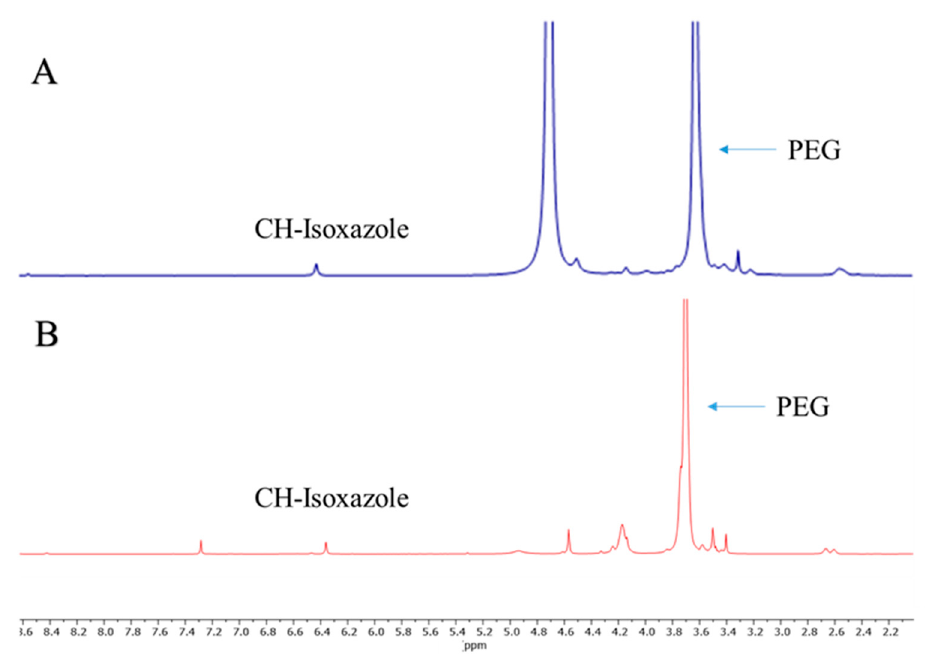
Scheme 2. Synthesis of isoxazole-mPEG architectural polymer ( 11 ).